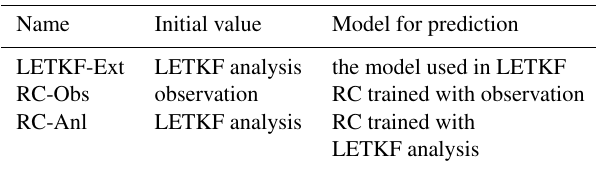
Obs, no longer exists in RC-Anl. Although the prediction ac- curacy is lower than LETKF-Ext (Fig. 7a), our new method indicates a robustness to the observation sparsity and over- comes the limitation of the standalone RC.